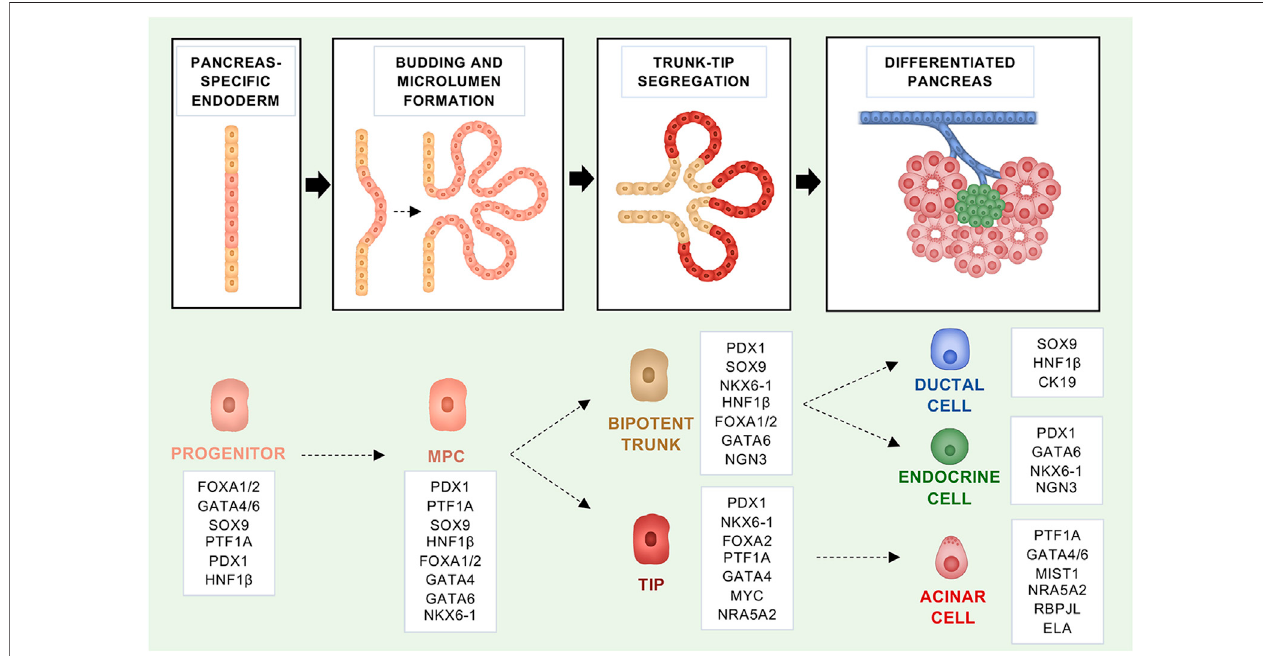
FIGURE 1 | Fate regulators that govern the embryonic development of the mouse pancreas and maintain identity in the adult organ. Schematic representation of the embryonic mouse pancreas development. In boxes, the fate regulators for each developmental stage are highlighted.